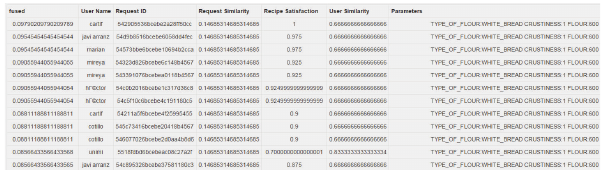
Figure 7: SandS recipe request similarity resulting